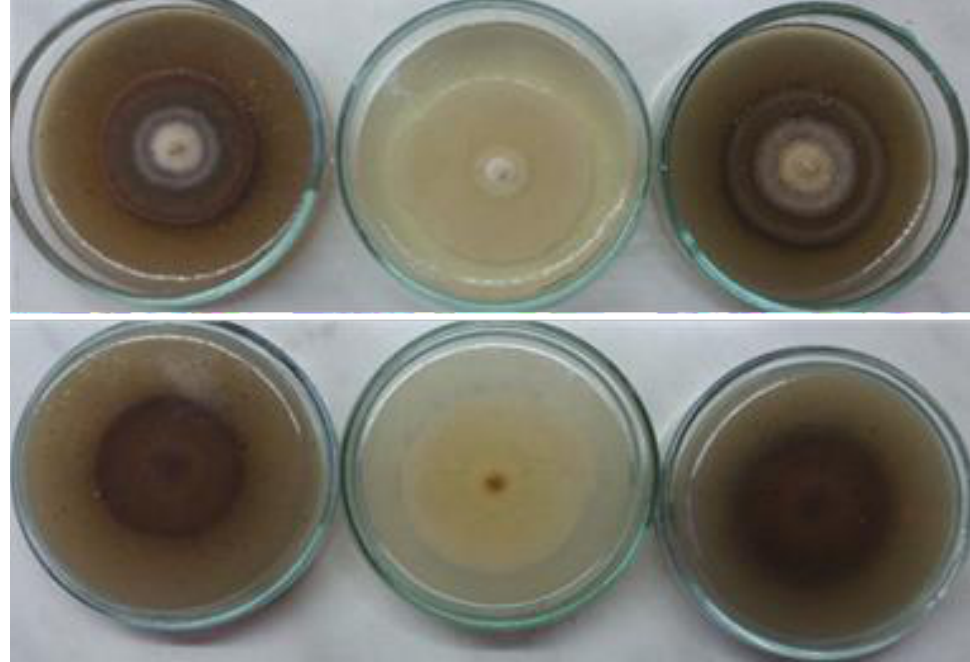
Figure 5. Colony differences of Neofabraea alba isolate J45/2, grown on oatmeal agar plates (OA) at 20 °C for 14 days in multiple transfers from the same inoculum source.